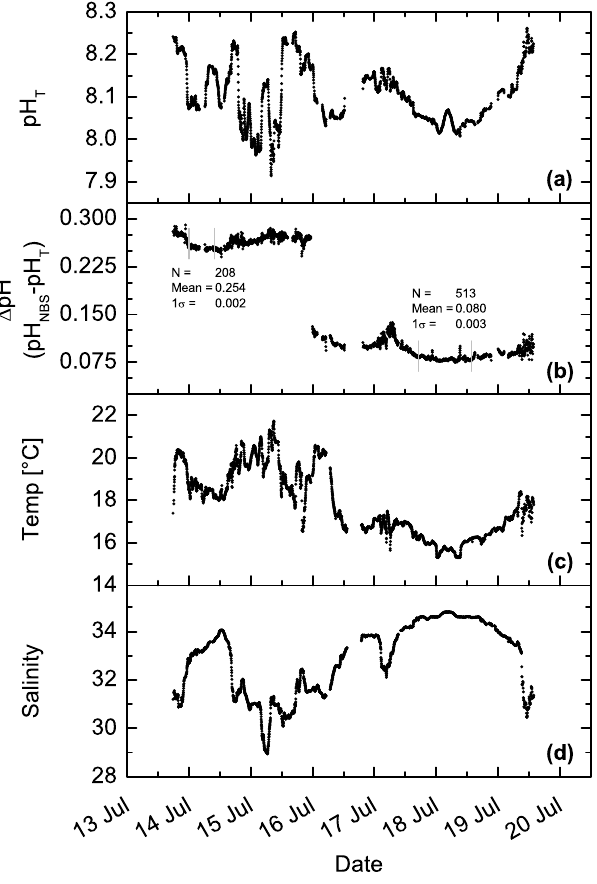
Fig. 9. In-situ data of a cruise in the North Sea from 13 to 19 July 2010. (a) Optically measured pH T . (b) Differences of potentiomet- ric and spectrophotometric measured pH. A calibration of the glass electrode took place at 16 July. Before and after the calibration point, there are two sectors marked with low variations of S and T . Mean and standard deviation are calculated for these regions. (c) Temperature measured in the FerryBox. (d) Salinity measured in the